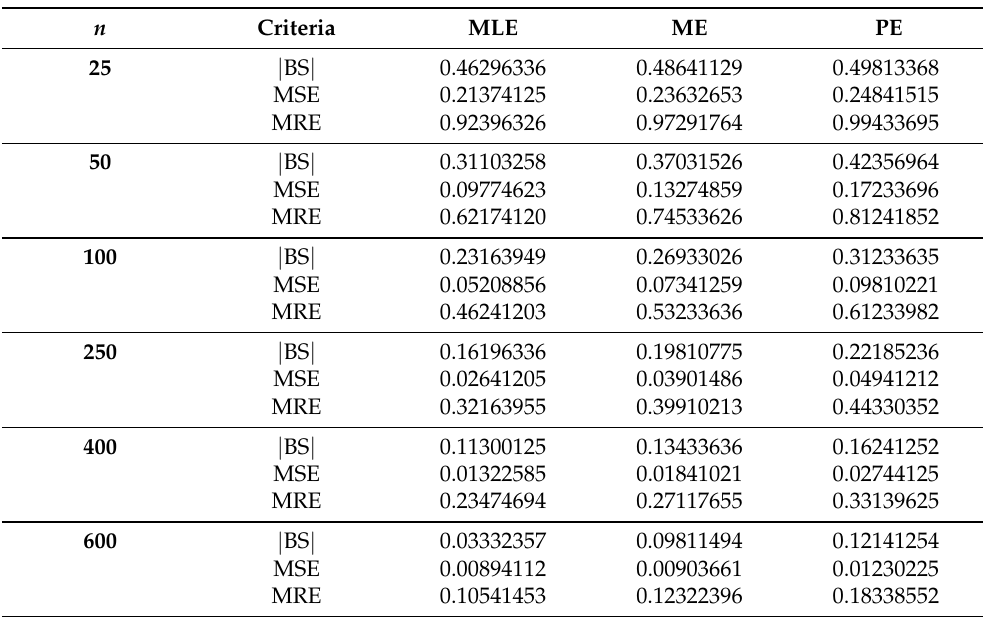
Figure 6. Simulation visualization plots for β = 0.35. Table 5. Simulation results for β =